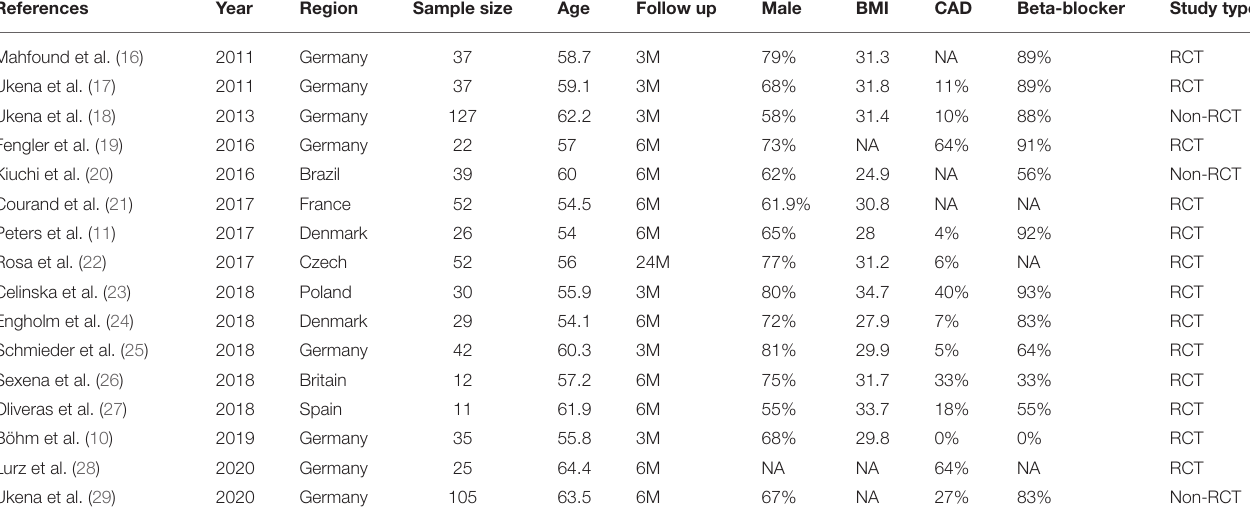
TABLE 1 | Baseline characteristic of included